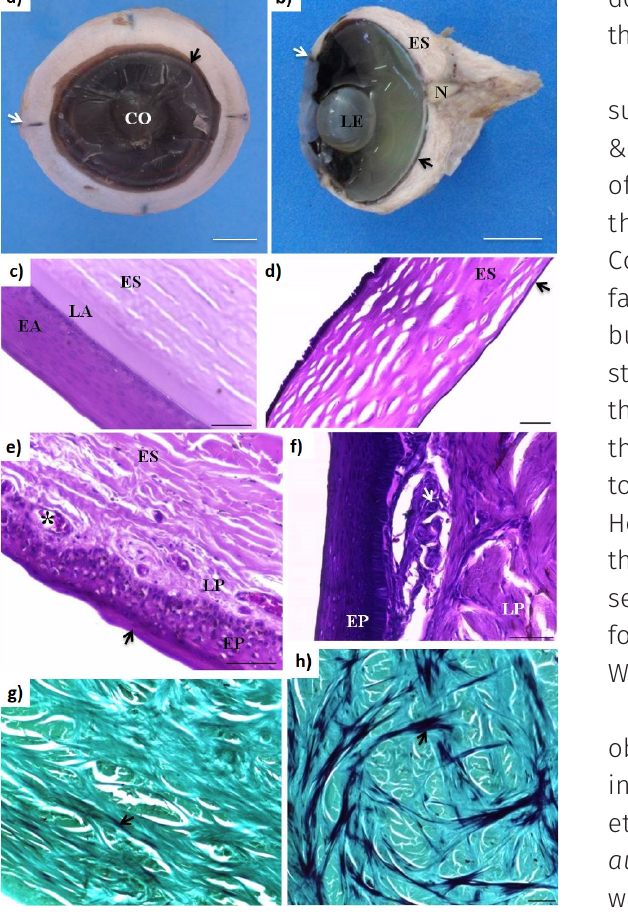
Figure 6. a) Dorsal, ventral, rostral and caudal vascularization (white arrow) of the cornea (CO) in the limbus region (black arrow). Bar: 1 cm. b) Median section for the visualization of the internal structures of the eye. LE – lens; ES – sclera; N – optical nerve; black arrow – choroid; white arrow– limbus. Bar: 1 cm. c) anterior epithelium (EA), anterior lamina (LA), and stroma (ES) of the cornea. Bar: 50 μm. HE. d) Stroma (ES) and posterior lamina (arrow) of the cornea in Stenella clymene . Bar: 50 μm. HE. e) Tenon capsule (arrow), squamous epithelium (EP), vascularized (asterisk) lamina propria (LP) and stroma (ES) of the sclera in Guiana dolphin. Bar: 50 μm. HE. f) Presence of mechanoreceptors (arrow) in the lamina propria (LP) of the sclera in Stenella clymene . EP – epithelium. Bar: 50 μm. HE. g) and h) Stroma of the sclera in Sotalia guianensis and Stenella clymene with melanin accumulation (arrow), respectively. Bar: 100 μm.